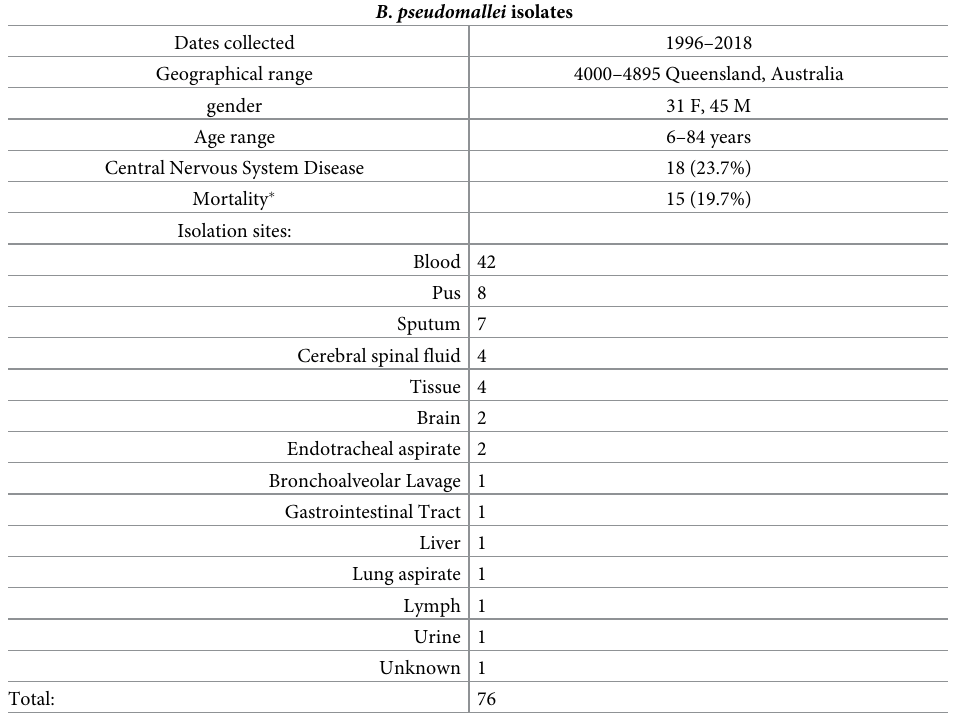
Table 1. Metadata regarding the B . pseudomallei isolates included in this